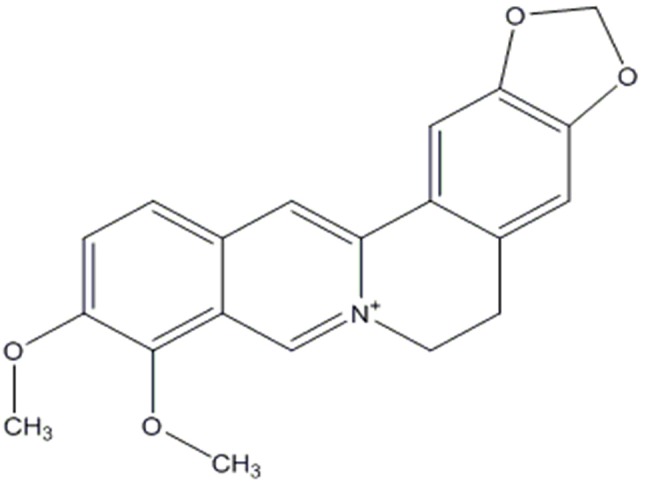
Chemical structure of berberine (Dong et al., 2012).